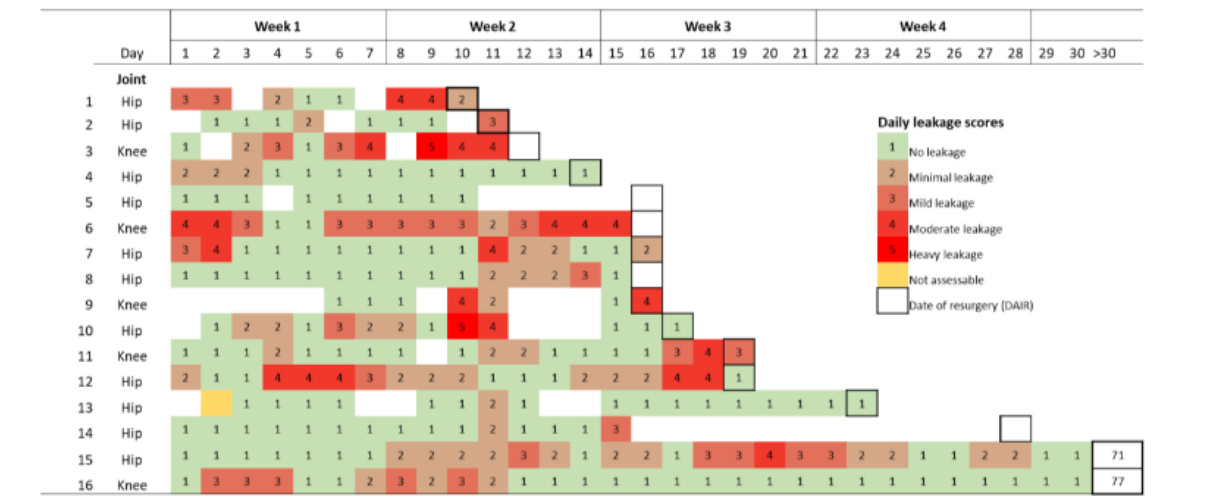
Table 5. Drainage scores in 16 patients who developed a prosthetic joint